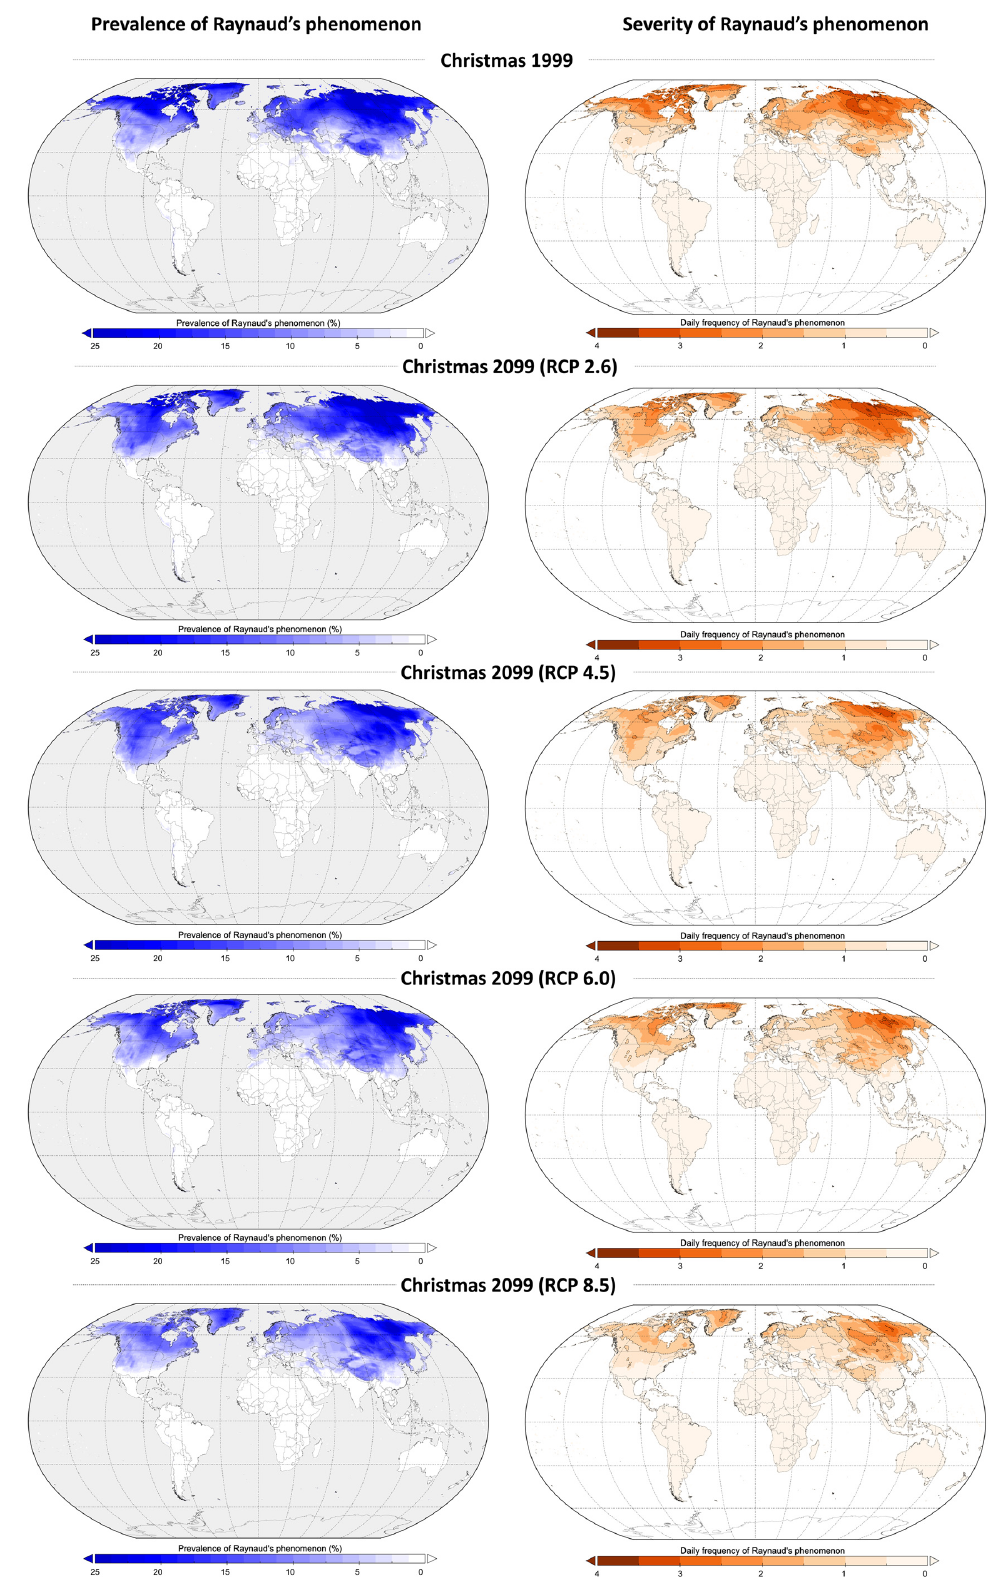
Figure 1. Prevalence and daily frequency of Raynaud’s phenomenon during Christmas 1999 and Christmas 2099 according to four greenhouse gas emission scenarios (Representative Concentration Pathway (RCP) 2.6, RCP4.5, RCP6.0, and